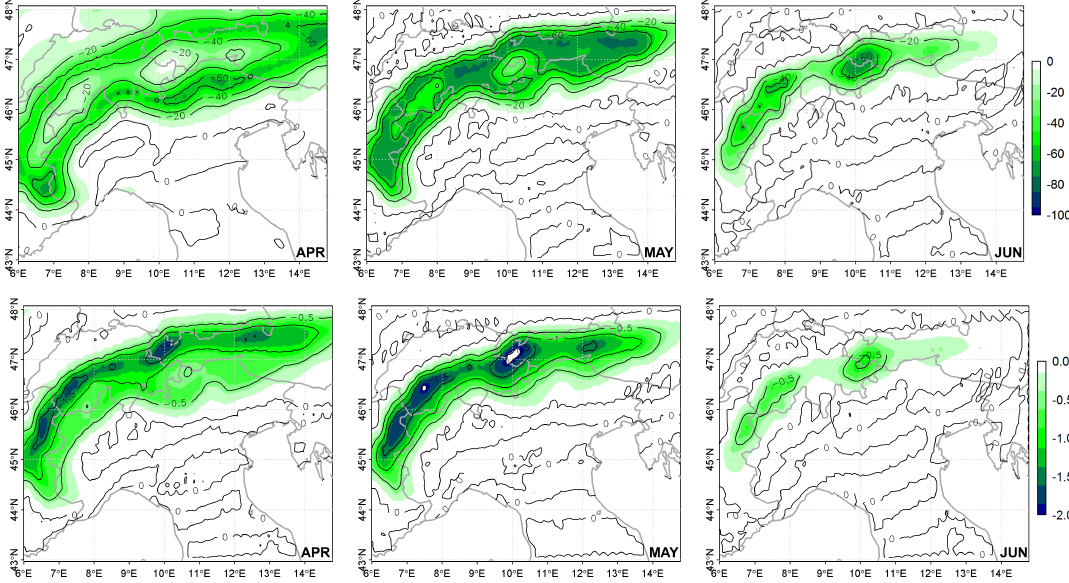
Figure 6. Differences between FC A 2 and the RC in snow cover (in %; upper panels ) and in snow depth (in m; lower panels ) for April, May, and